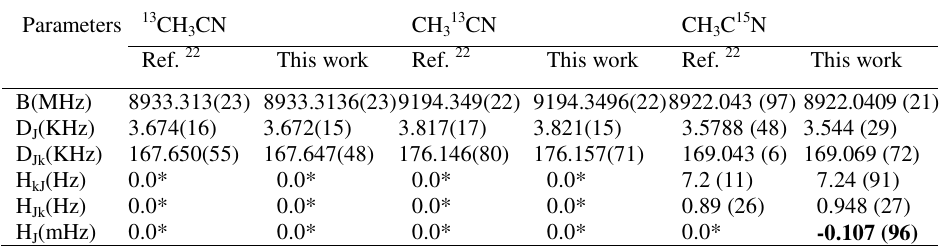
Table 7 . Comparison of ground rotational parameters of 13 CH with previous works.